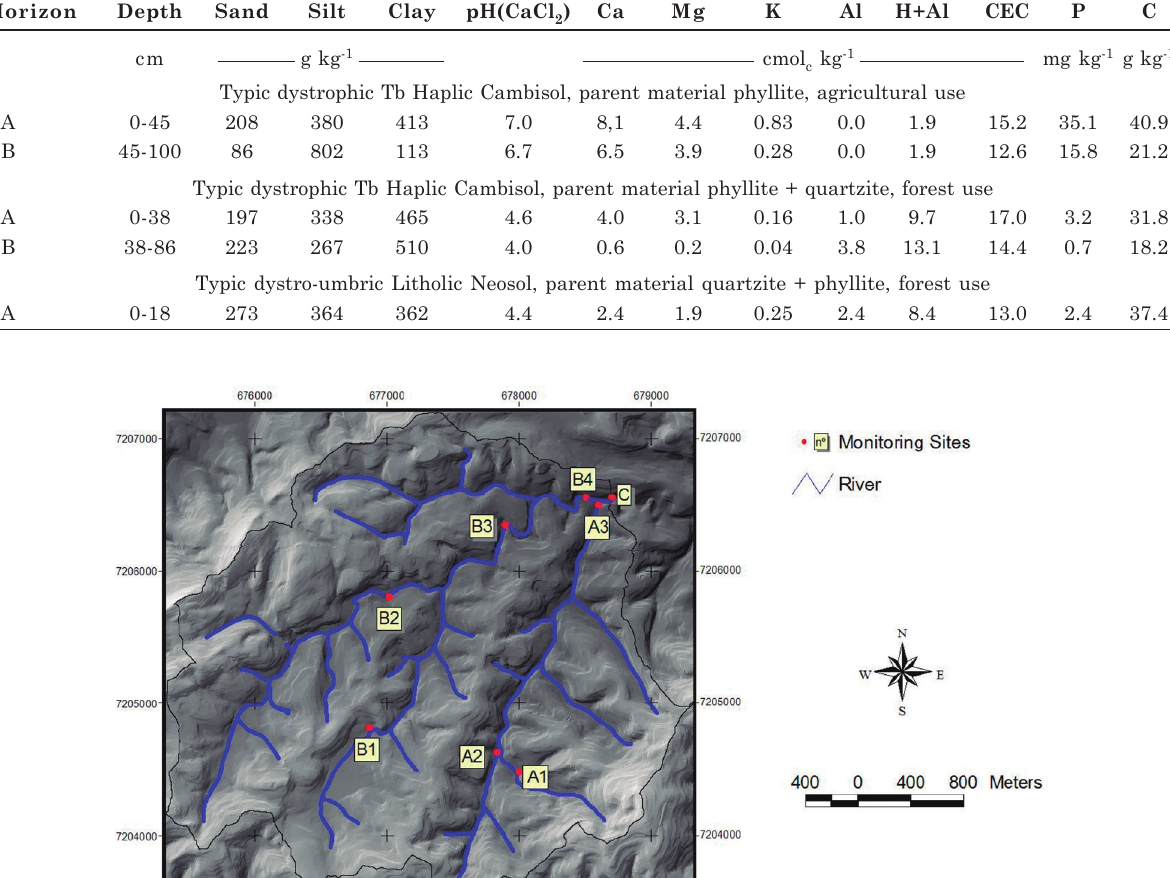
Table 1. Particle size distribution and chemical attributes of two soil profiles (Haplic Cambisol and Litholic